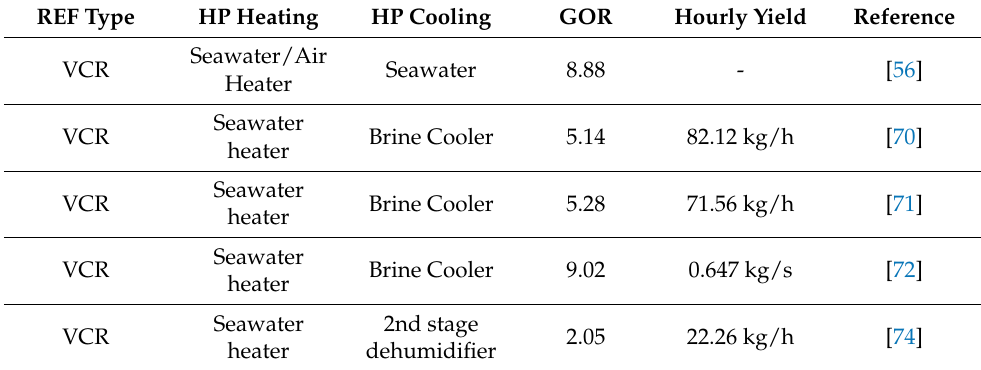
Table 2. Summary of performance of various HDH–REF